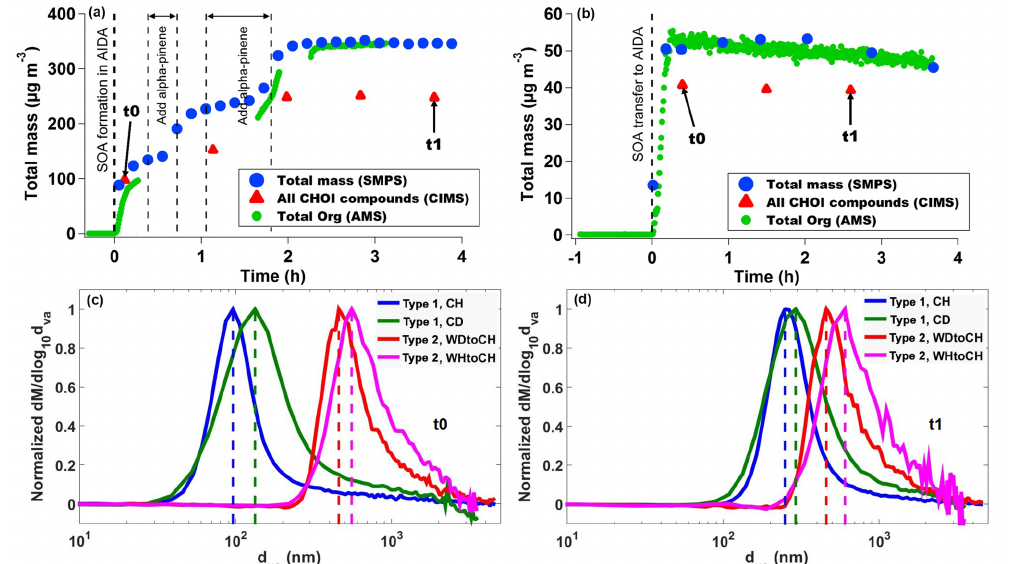
Figure 2. (a) Particle mass concentrations derived from SMPS size distributions (blue circles), CHOI mass concentrations measured by CIMS (red triangles), and organic mass concentrations measured by AMS (green circles) representative of type 1 experiments (here CH), (b) rep- resentative of type 2 experiments (here WDtoCH). Data were not wall-loss-corrected. t 0 and t 1 indicate points in time used for comparisons in this study. Averaged size distributions measured by AMS at t 0 (c) and (d) t 1 for the four